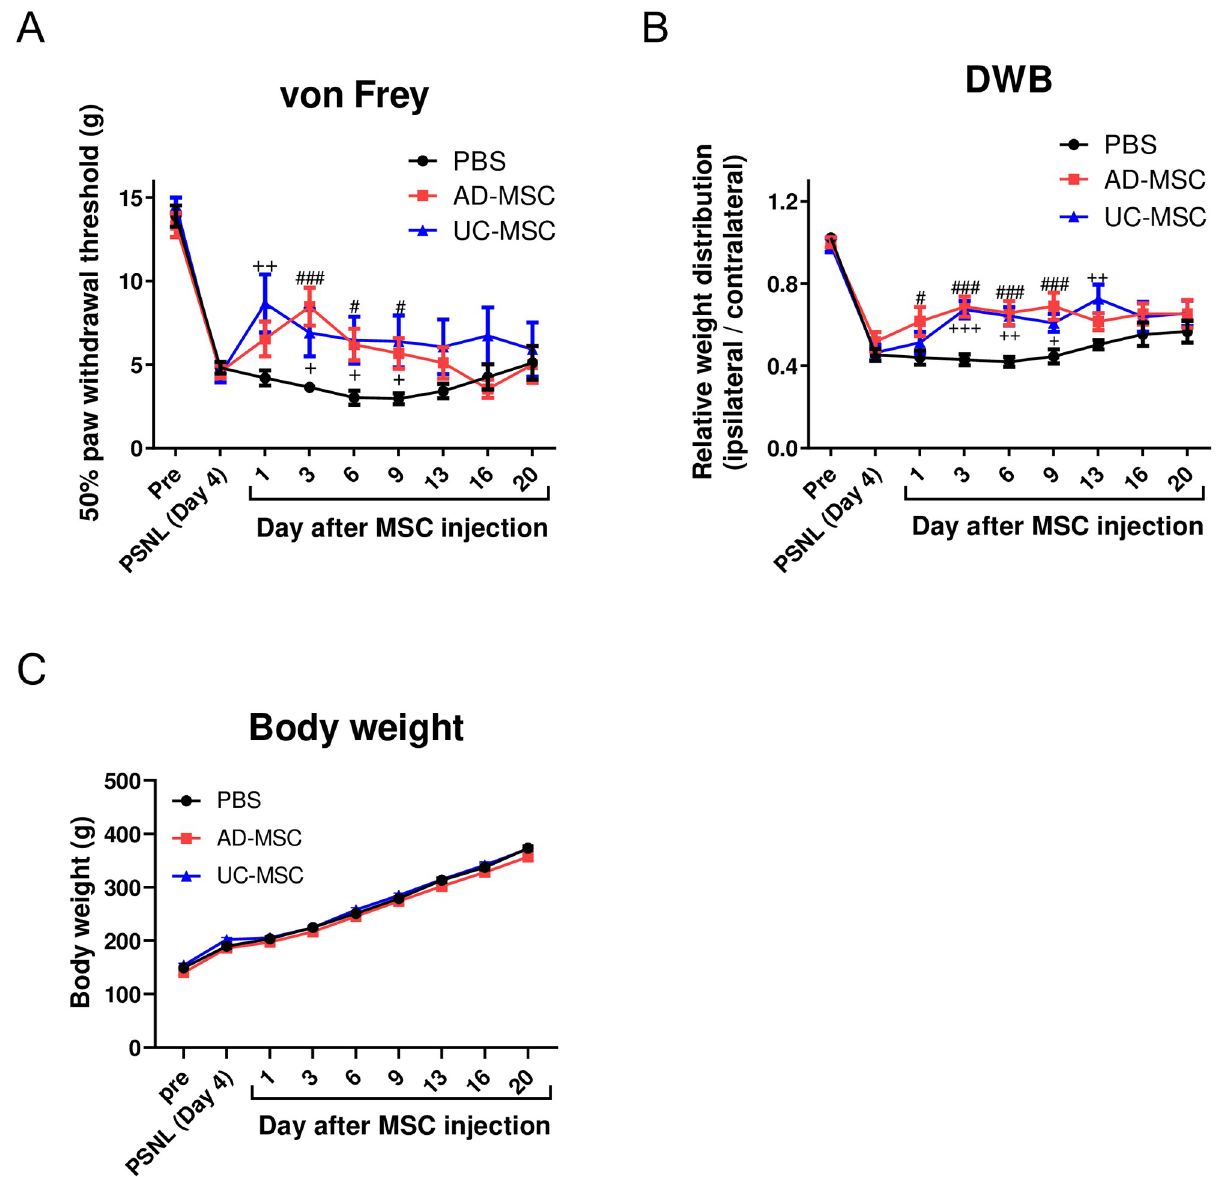
Fig 1. Effects of AD- and UC-MSCs on PSNL-induced pain. On day 4 after PSNL, AD-MSCs, UC-MSCs (5 × 10 6 cells/mL), or its vehicle (PBS; 1 mL) was administered intravenously to rats, and the von Frey (A, PBS; n = 17, AD-MSC; n = 18, UC-MSC; n = 10) and DWB tests (B, PBS; n = 18, AD-MSC; n = 16, UC-MSC; n = 12) were performed, and body weight (C, PBS; n = 18, AD-MSC; n = 16, UC-MSC; n = 12) was measured. The data are expressed as mean ± standard error of the mean. # and ### indicate p < 0.05 and 0.001, respectively, sham vs. AD-MSC group; + , ++ , and +++ indicate p < 0.05, 0.01, and 0.001, respectively, sham vs. UC-MSC group: Bonferroni’s multiple comparison test was performed following a two-way analysis of variance.